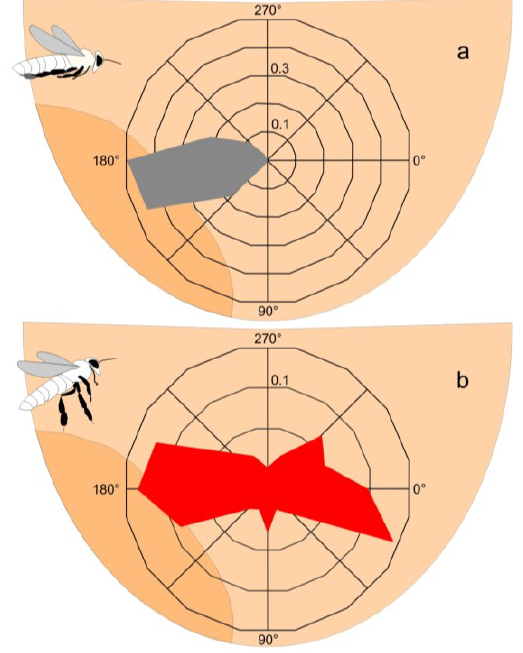
Figure 2. Flight characteristics of ( a ) “nestmate” forager bees ( fb ) homing to the mother nest ( expN .) and ( b ) of “non-nestmate” scouts ( sc , originating from a migration swarm 1 nearby) while exhibiting erratic flight patterns in front of expN . The round diagrams 1 illustrate the angular distributions of the flight paths as assessed in a frame-by-frame analysis; sector lines (abscissa) give the image-based flight angles (definition of directions: 0°, from the left to the right; 90°, from the top to the bottom; 180°, from the right to the left; 270°, from the bottom to the top); the ordinates show the relative number of cases. ( a ) Homing foragers flew straight towards the nest (grey plot; n = 30), keeping the legs fb stretched along the body’s length axis (see scheme); ( b ) The “non-nestmate” scouts sequentially approached expN from the left side and retreated again back to the same side 1 (red plot; n = 8), with their third pair of legs splayed from the body (see scheme). Light sc tan background area, the experimental nest ( expN ): dark tan area, the mouth zone of the 1 nest (see Movies